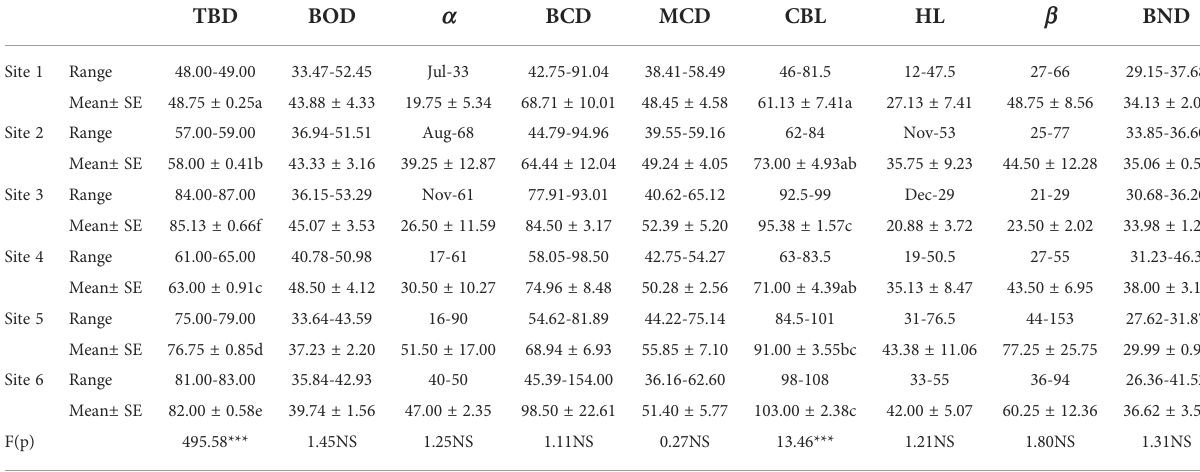
TABLE 1A. Burrow morphology nomenclature of Helice tientsinensis at each site. Table 1B. Burrow morphology nomenclature of Helice tientsinensis at each site. BOD